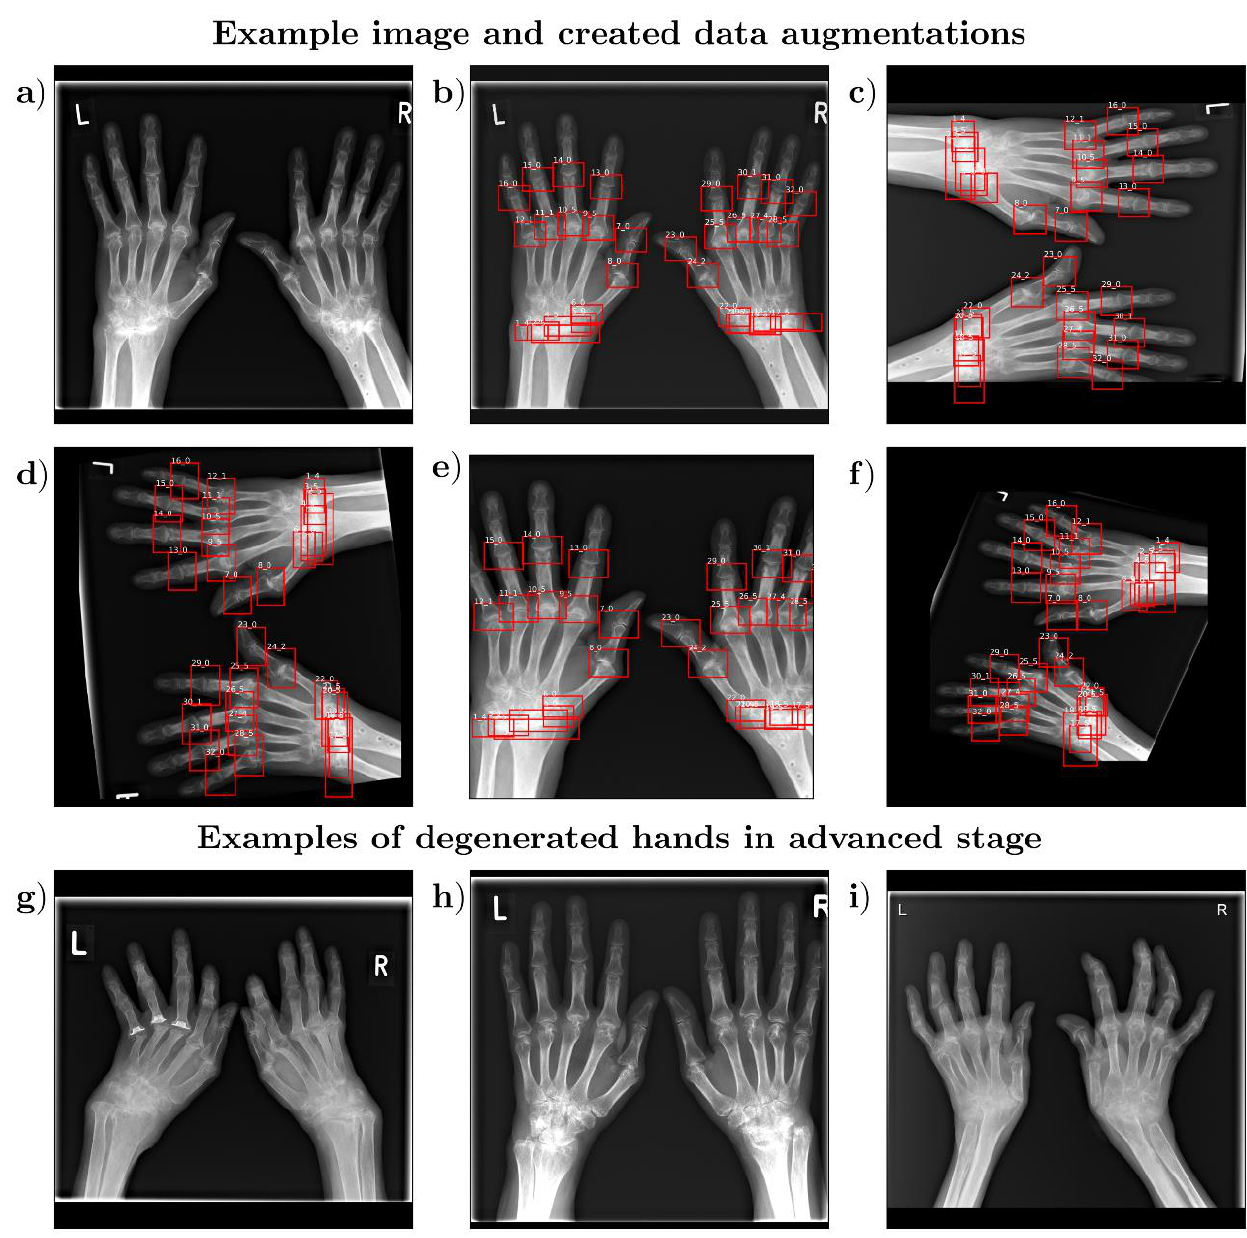
Figure 2. Representative visualization of a hand and its data expansion, as well as example images for hands in the degenerated stage. Shown are the original radiograph without the bounding boxes ( a ) as well as with the bounding boxes ( b ) and four exemplary baseline examples ( c – f ) after data expansion, including the marked bounding boxes of P.S. (rheumatologist with 15 years of experience). Two numbers are indicated above each bounding box, separated by an underscore. Here, the first number represents the number of the joint (1–32), and the second represents the specific erosion value. Furthermore, three hands in the advanced stage of degeneration ( g – i ) are shown, which were in the test data set to allow a complete evaluation of the accuracy of the